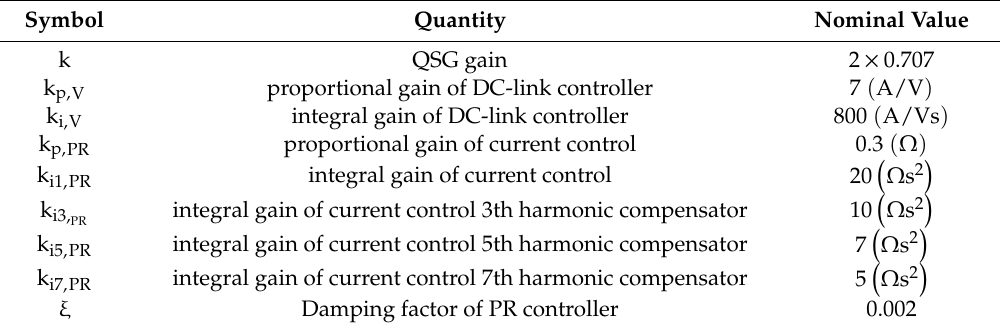
Figure 15. Zero-pole map and the open-loop Bode plot of the voltage control loop. Table 1. PV system